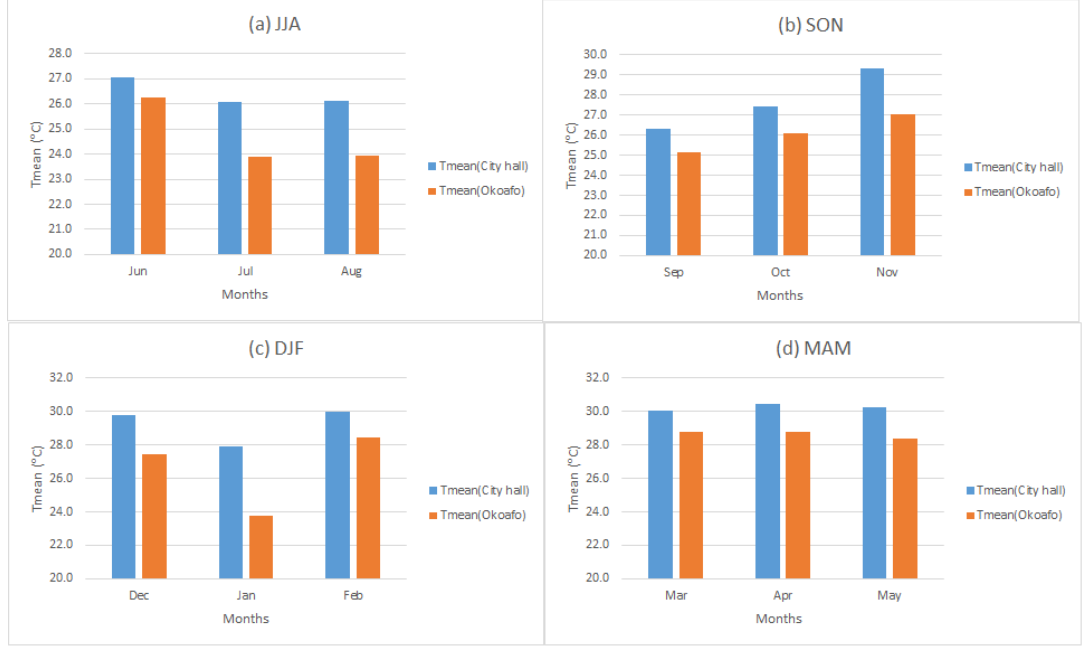
Figure 4. Seasonal distribution of Tmean at City hall and Okoafo in ( a ) JJA; ( b ) SON; ( c ) DJF and ( d ) MAM.